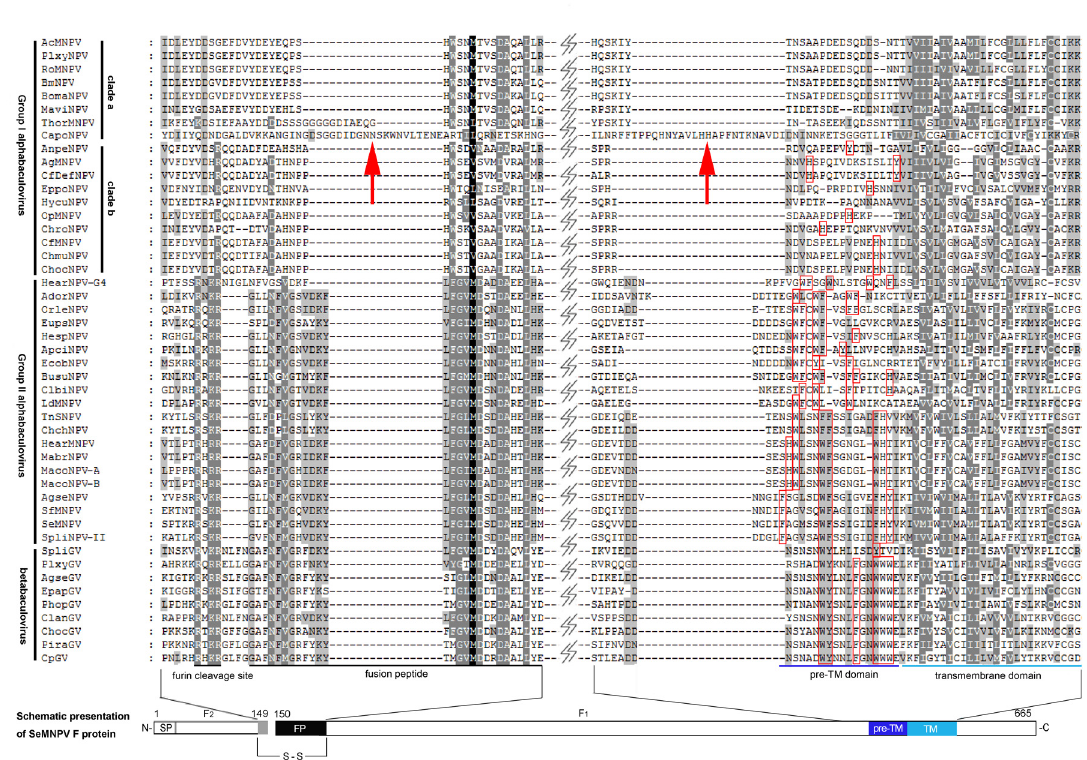
Fig 5. The amino acid alignment of F and F-like proteins. The alignment was performed using ClusterW method. A schematic figure of SeMNPV F protein was adapted from a previous publication [45] and is shown at the bottom, and two enlarged regions with sequence alignments are also shown. Viral names and categories are on the left. The predicted regions of furin cleavage site, fusion peptide, pre-TM and transmembrane domains are indicated below the alignment. The red square shows the aromatic amino acids (F, Y, W and H) in the pre-TM region. The arrows point to the insertion regions in CapoNPV. Black background shows greater than 80% identity among compared regions, dark gray and light gray shows greater than 50% and 30% identity,